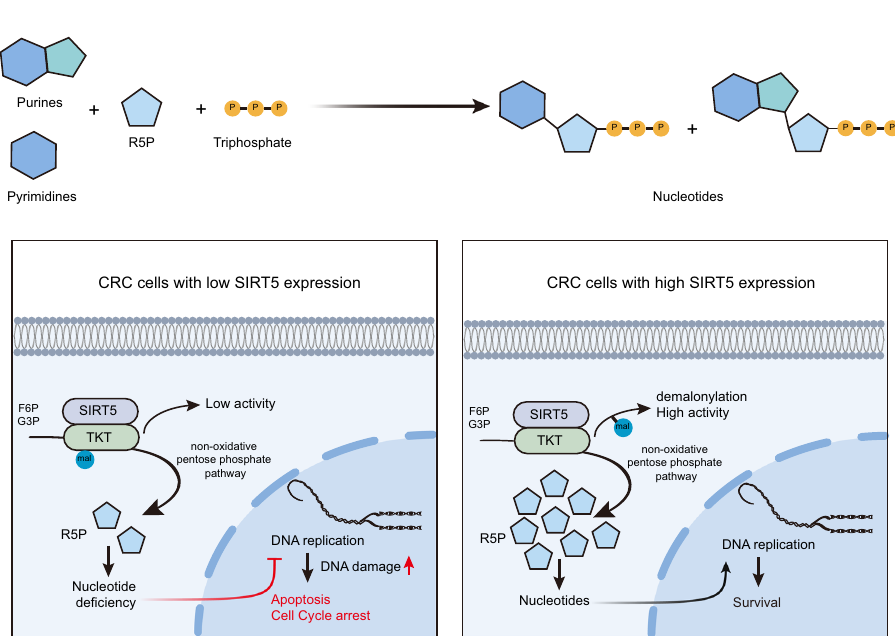
Fig. 9 | Schematic model showing that SIRT5 promotes the non-oxidative PPP by interacting with TKT, resulting in TKT demalonylation and activation. This maintains intracellular R5P and nucleotide levels, which supports CRC cell